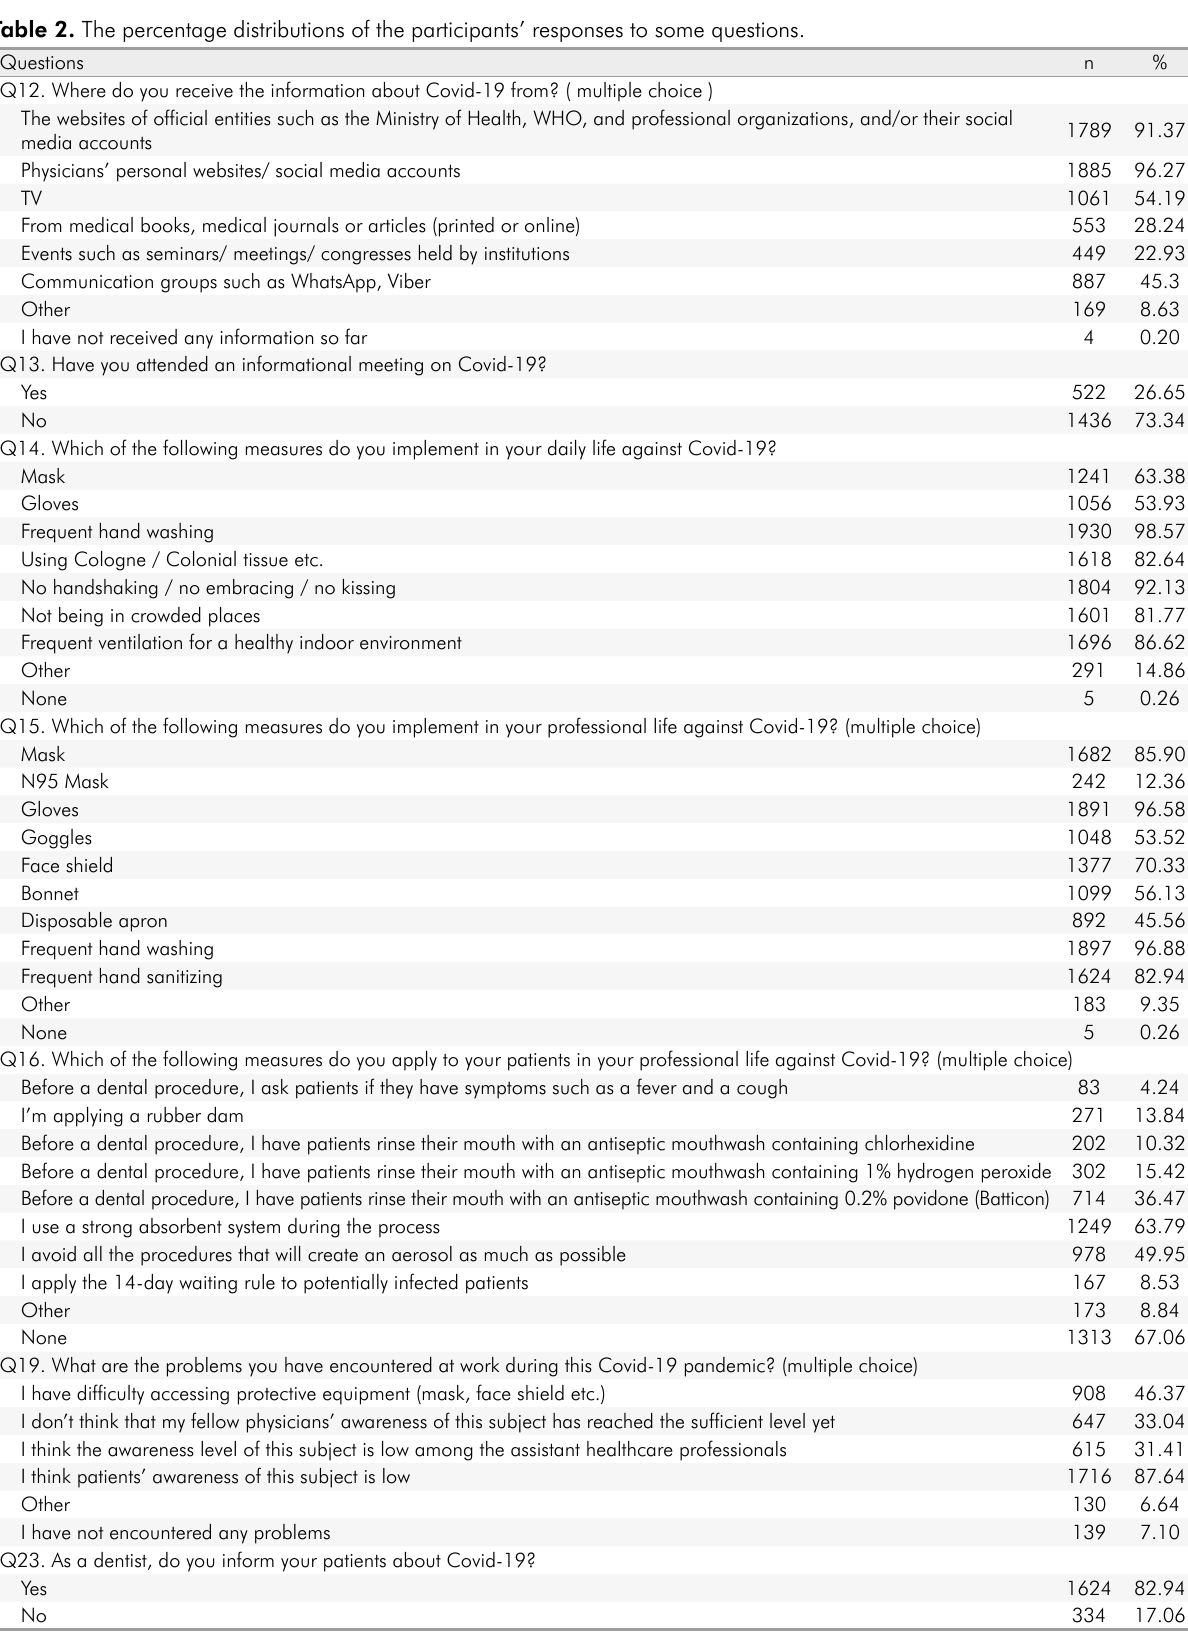
Table 2. The percentage distributions of the participants’ responses to some